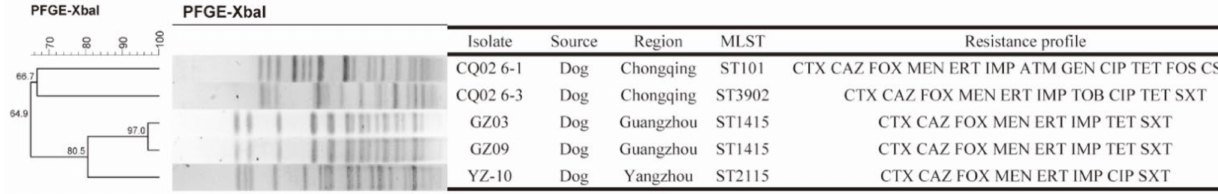
Figure 3. Clonal relationship, plasmid characteristics and antibiotic resistance phenotype of the five bla NDM-5 -positive E. coli isolates. Dendrograms based on Xba I-restriction patterns of E. coli isolates producing NDM-5. The number on the left represents the similarity between corresponding strains. E. coli isolates showing similarities of <85% were considered to be unrelated. CTX,